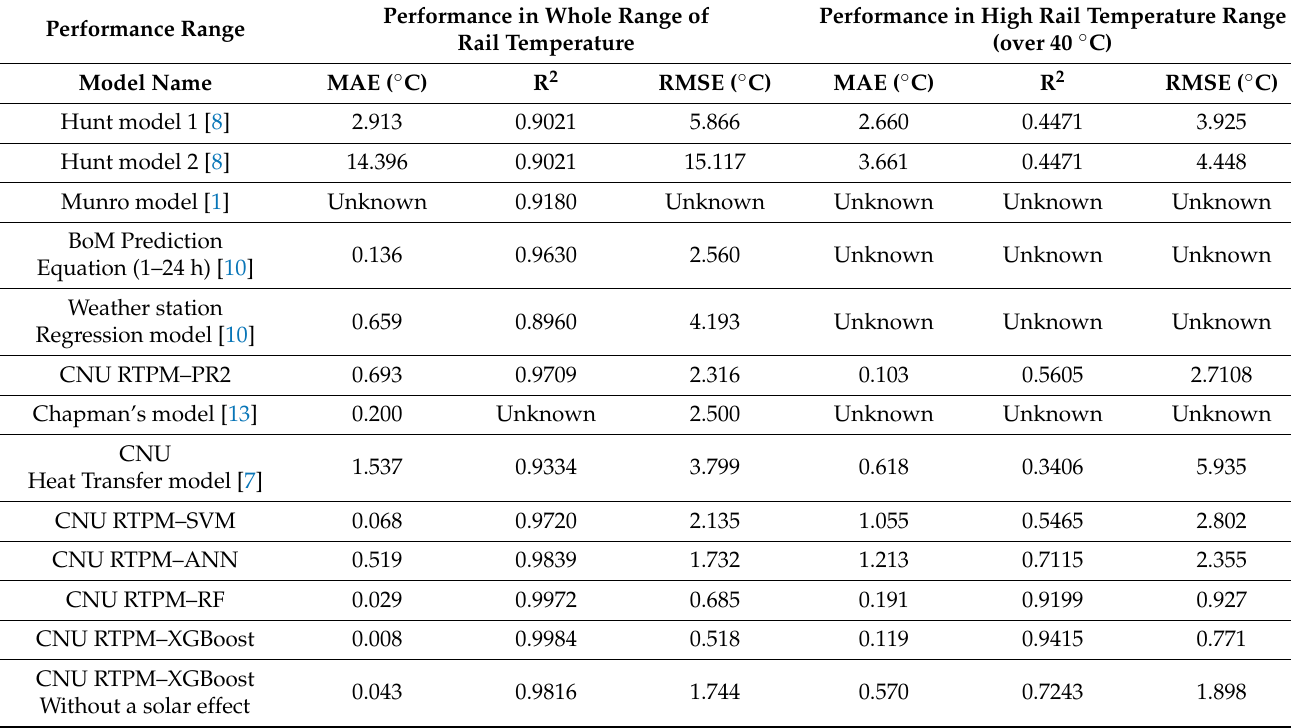
Table 1. Comparison of prediction errors in previous RTPMs and CNU